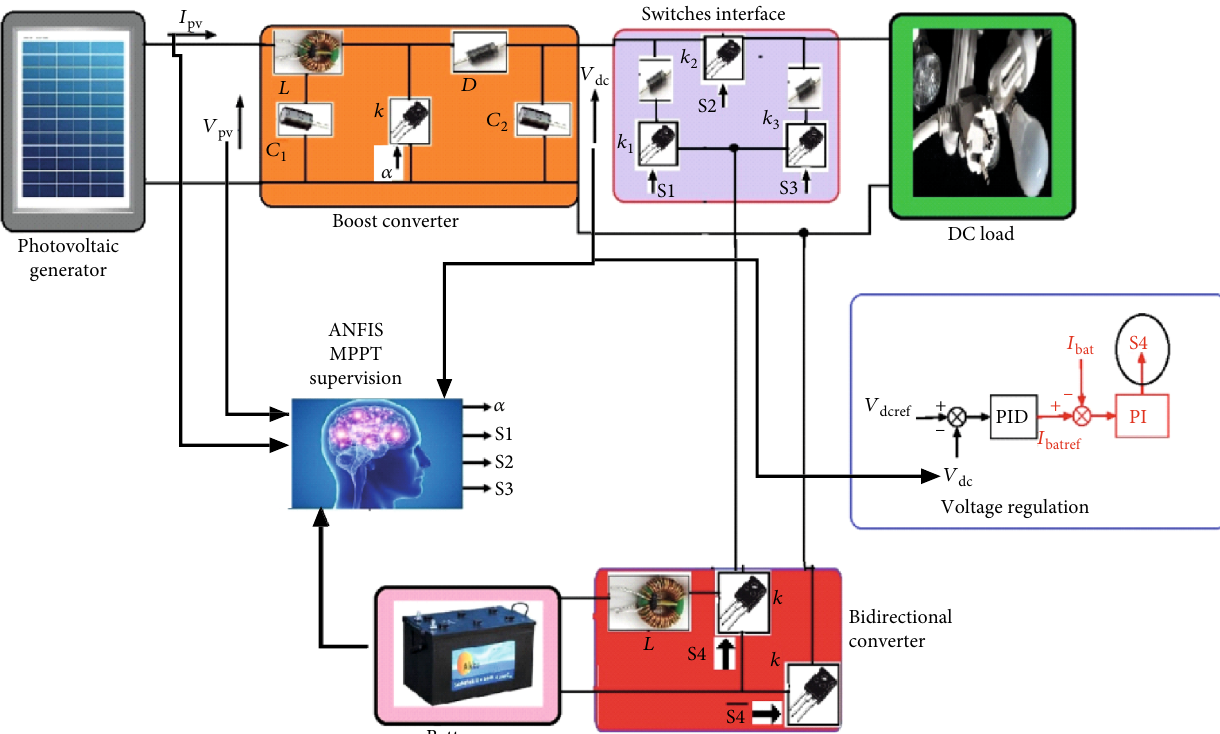
Figure 1: Block diagram of the studied